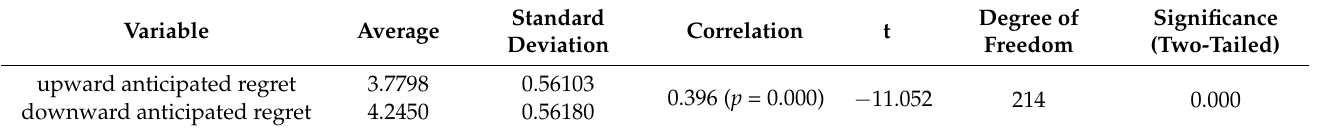
Table 7. The impact of quantity-limited promotions on anticipated